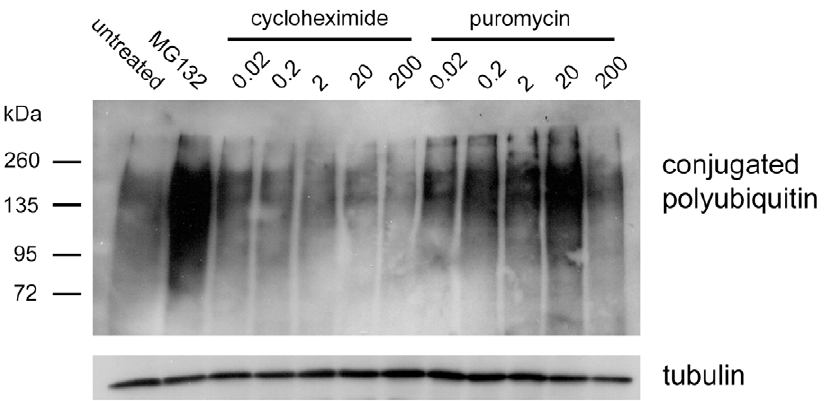
Figure 8. Puromycin treatment leads to increased levels of polyubiquitinated proteins. 293-K b cells were treated for 4 hours with media alone, 20 m M MG132, or the indicated concentrations of cycloheximide and puromycin ( m M). Lysates were subjected to Western blotting with FK2 ( upper panel ), a monoclonal antibody specific for mono- and polyubiquitinated protein conjugates. Beta-tubulin was probed as a loading control ( lower panel ). Results are representative of three independent experiments.